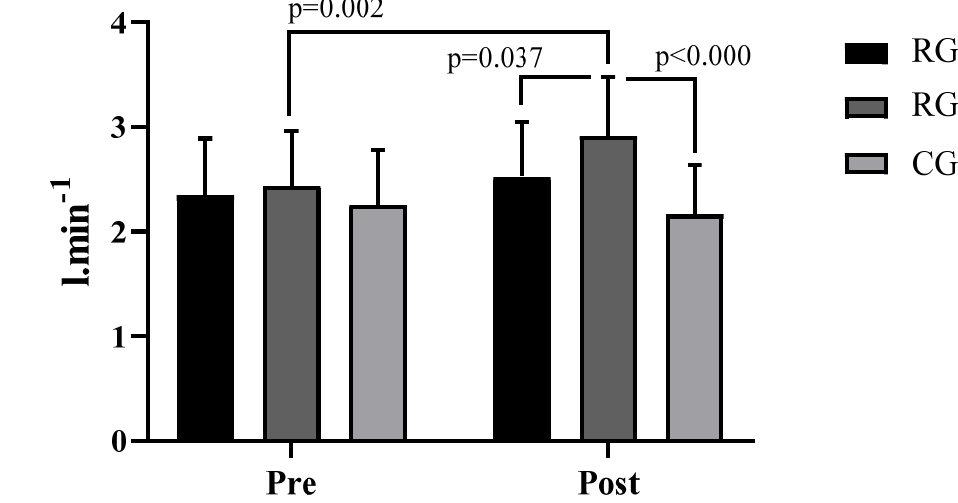
Figure 3. VO 2max absolute for the groups before and after the intervention. Figure 3. VO 2 max absolute for the groups before and after the intervention.